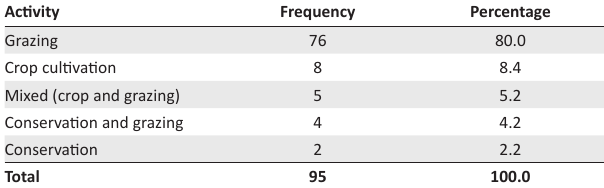
TABLE 10: Dominant land use within the sampled